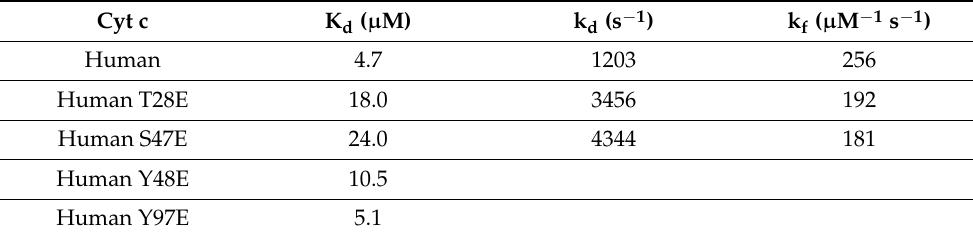
Table 2. Human Phosphomimetic Mutant